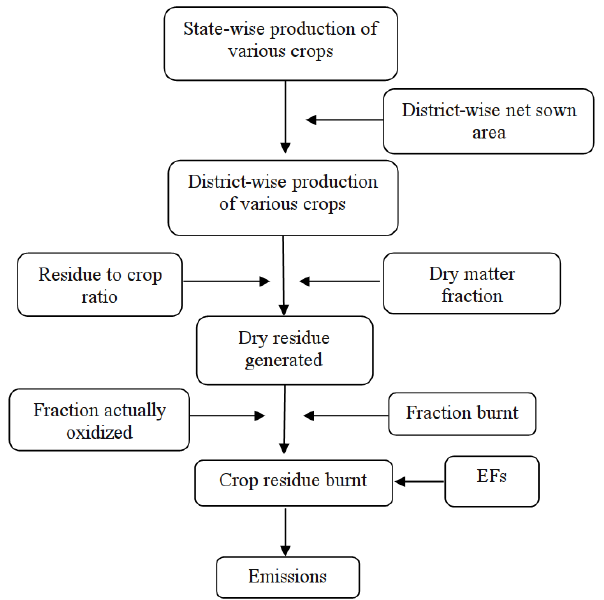
Figure 5. Flow chart for the calculation of agricultural waste burn-